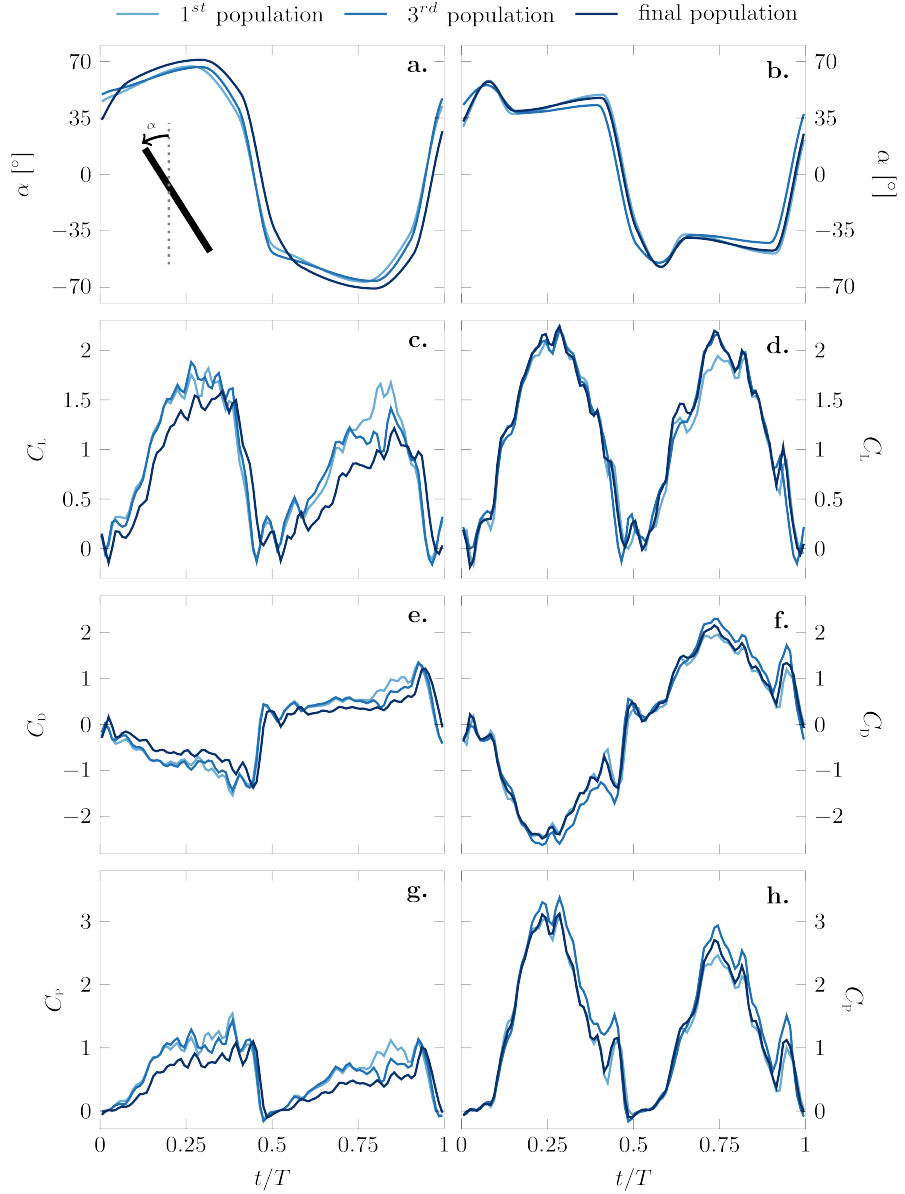
Figure 6. Phase averaged pitching angle α , lift coefficient C L , drag coefficient C D and power coefficient C P evolution for an entire flapping cycle for the best individuals from the initial, third and final population of the genetic algorithm efficiency optimization (left column) and lift optimization (right